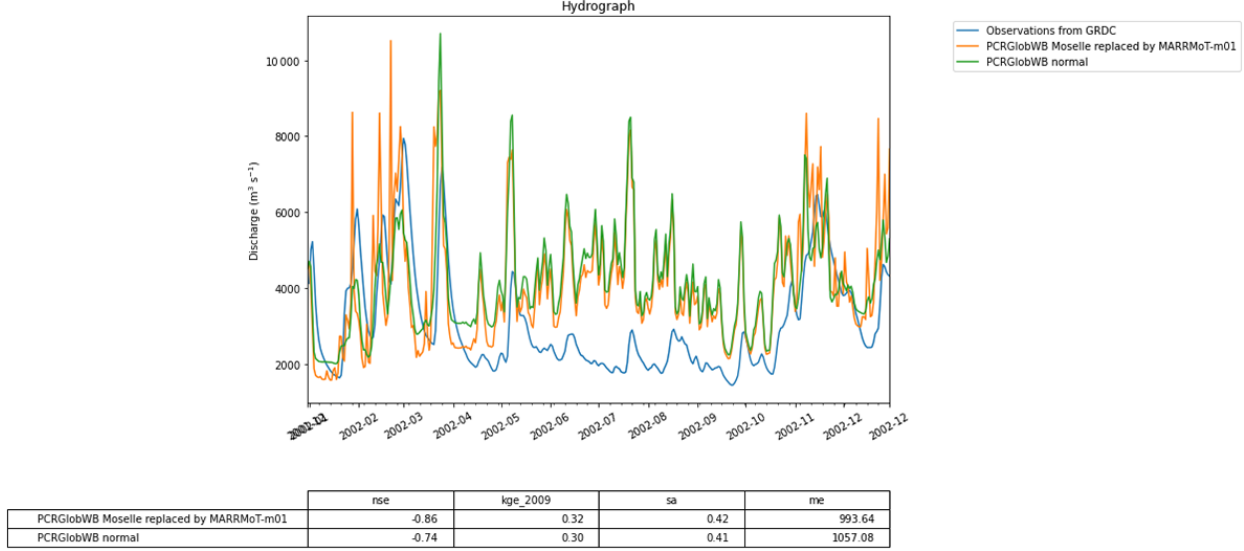
Figure 11. The calculated discharge for the Rhine basin from PCR-GlobWB 2.0 when run normally (i.e., the reference) and when coupled with MARRMoT for the Moselle subcatchment. The calculated discharge is compared to GRDC observations of discharge.